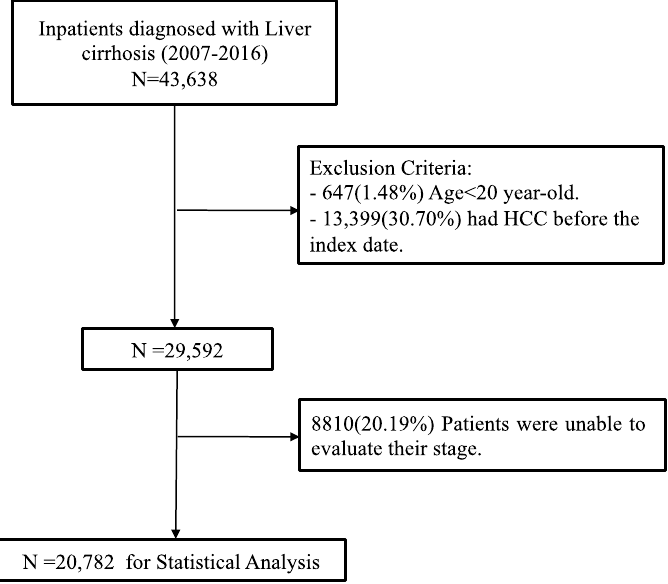
Figure 1. The flowchart for enrollment.